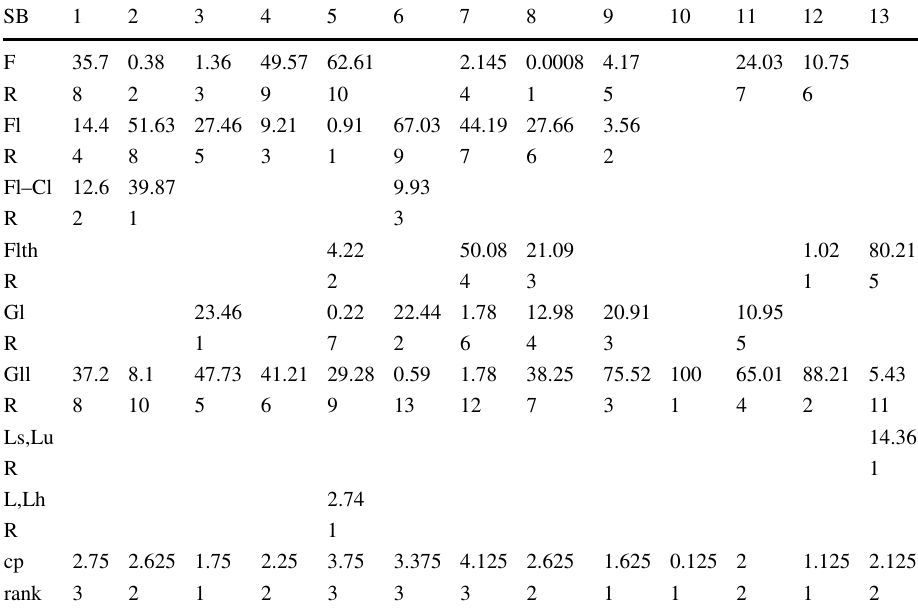
Applied Water Science (2019) 9:76 Table 10 Soil-based assigned ranking and compound value in Kansai–Kumari inter-fluvial site